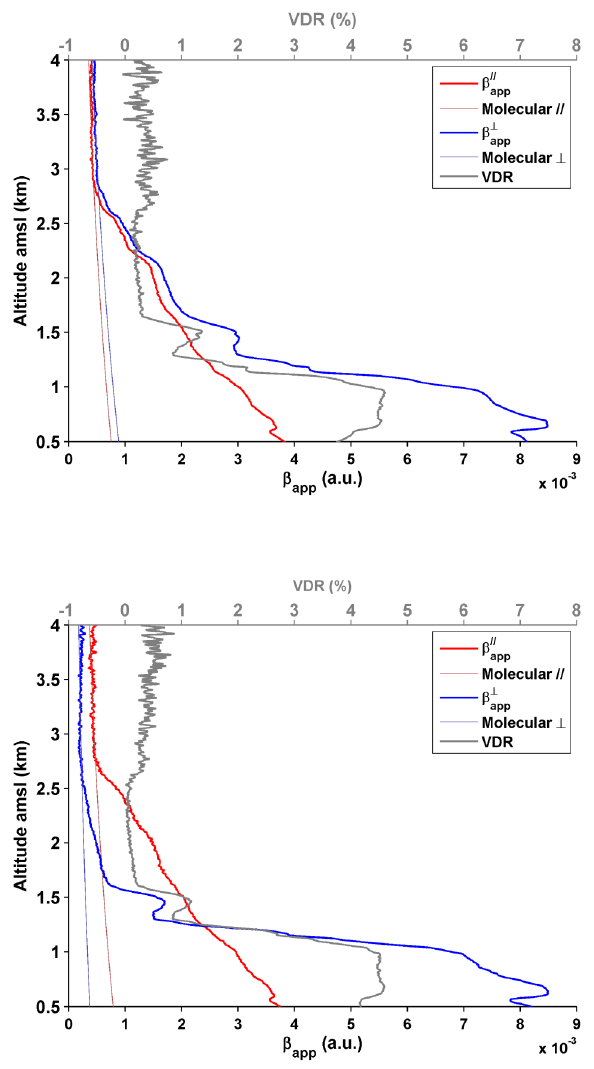
 and VDR for the 576 app